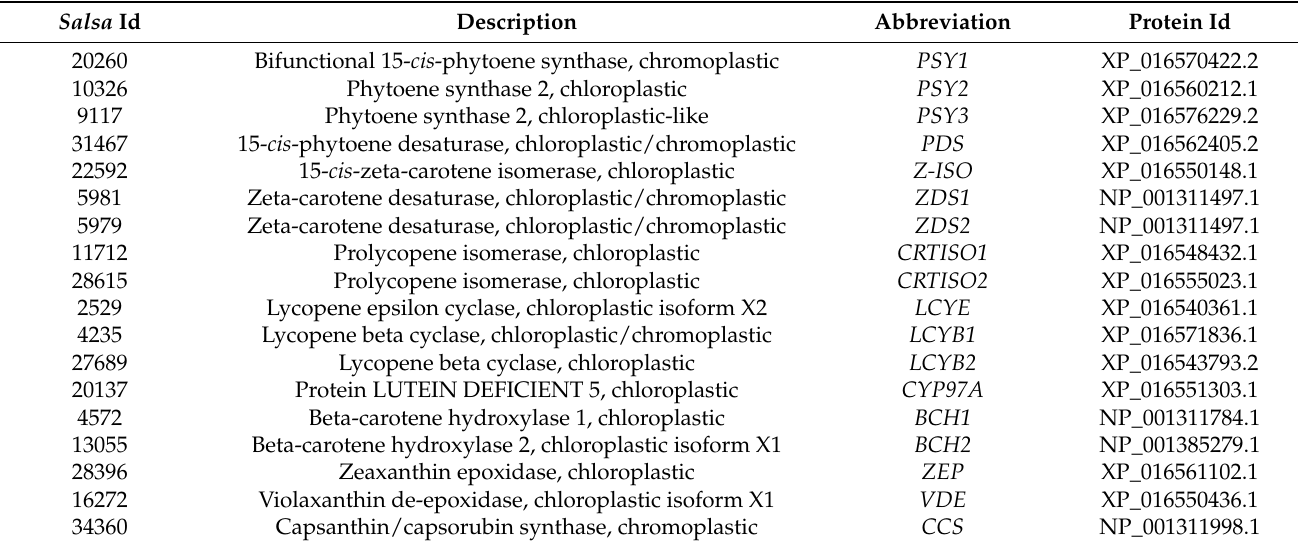
Table 2. Description of the analyzed target genes involved in carotenoid